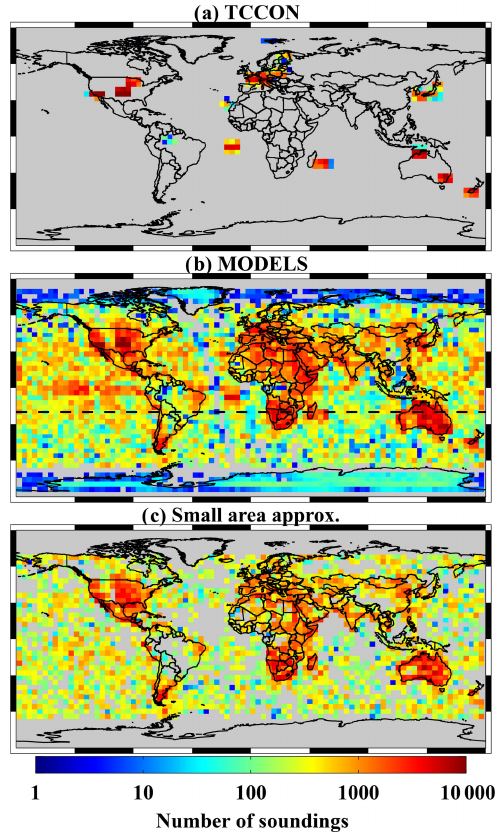
Figure 8. Sounding density of the truth proxy data in 4 ◦ × 4 ◦ bins used in the OCO-2 version 8 X CO filtering and bias correction. 2 (b) shows both the full global model-based truth proxy and the Southern Hemisphere truth proxy as the portion below the dashed black